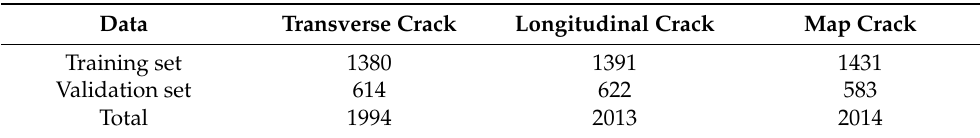
Table 5. Distribution of training samples for each type of disease.